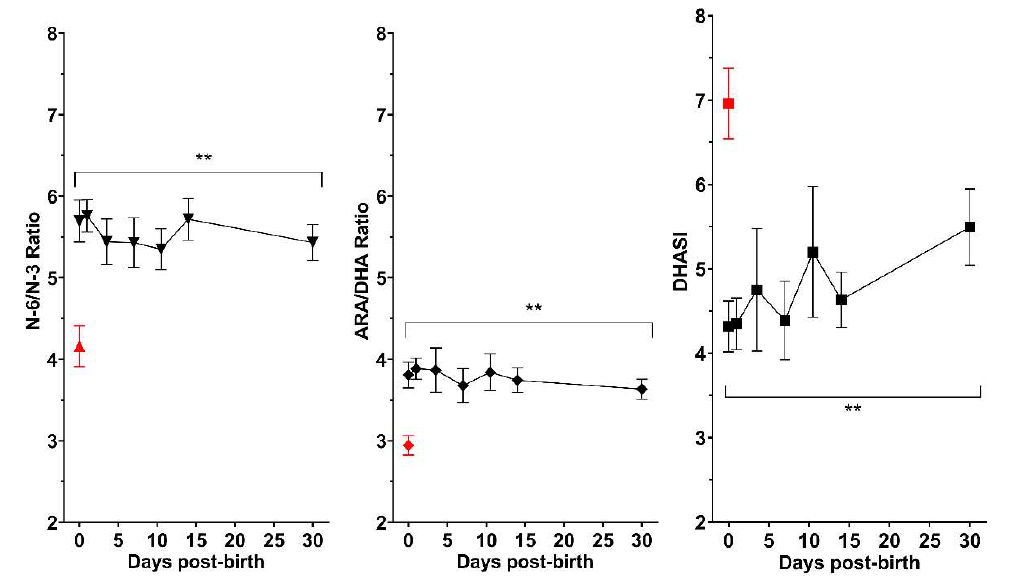
Figure 2. Evolution of fatty acids ratios in preterm neonates during the first 30 days of life as compared to mean values in term neonates at birth (red symbol). N-6/n-3 PUFAs ratio and ARA/DHA remained higher, whereas lower DHASI values persisted (ARA: arachidonic acid, DHA: docosahexaenoic acid; DHASI: DHA sufficiency index. (asterisks indicate statistically significant differences, p < 0.05).